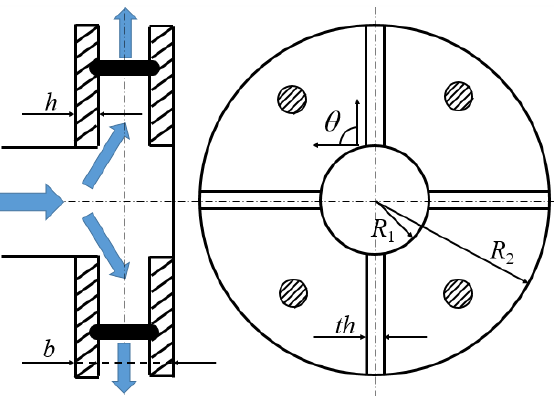
Figure 3. Sketch of a disc bladed impeller (four radial blades are represented in this figure instead of